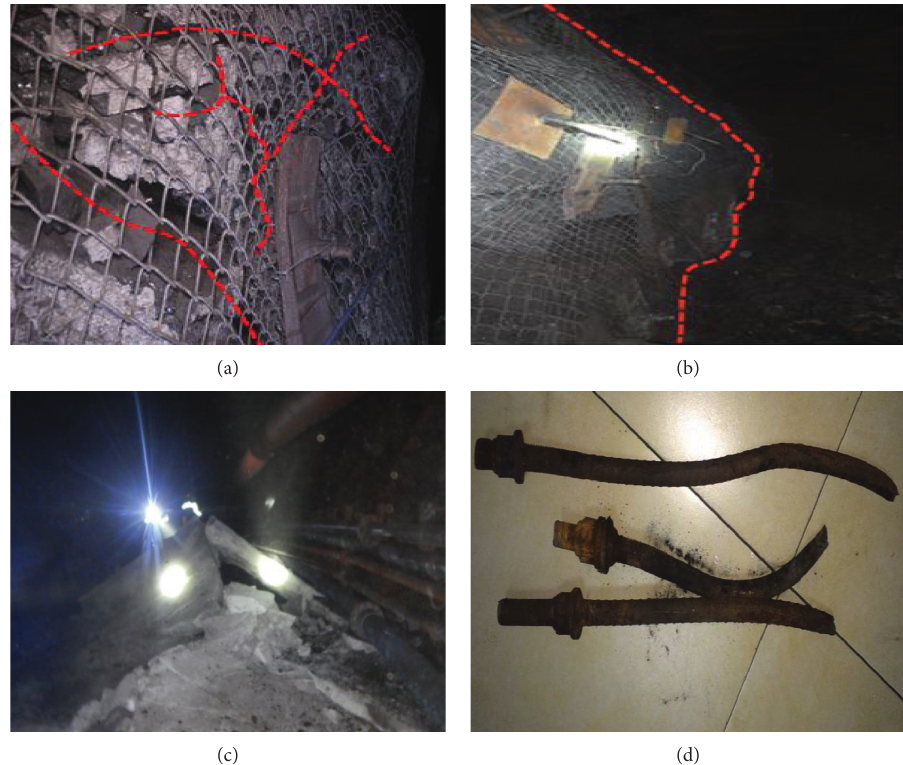
Figure 3: Roadway deformation: (a) coal wall cracks; (b) coal wall bulging; (c) floor warping and cracking; and (d) broken bolt.